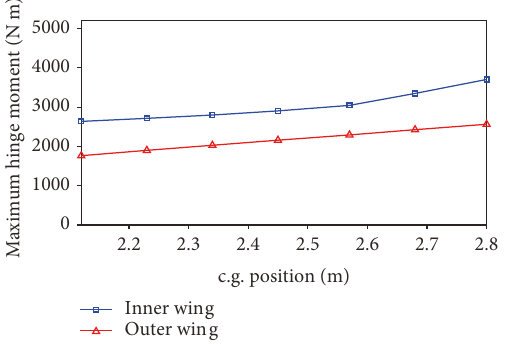
Figure 12: In fl uence of the c.g. position on the hinge